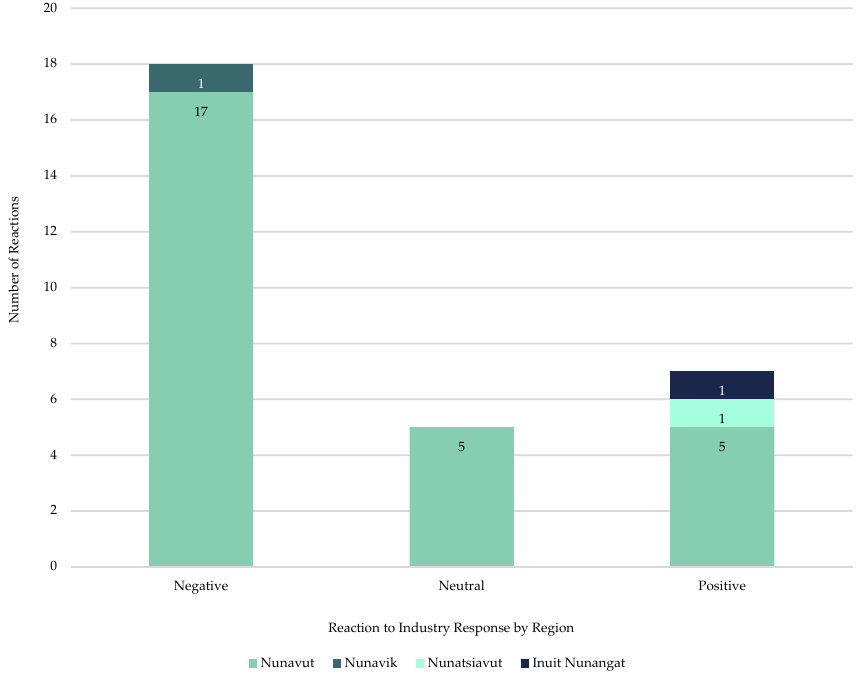
Figure 8. Reactions to Industry response to COVID-19, by region, in included articles on mining industry’s initial response